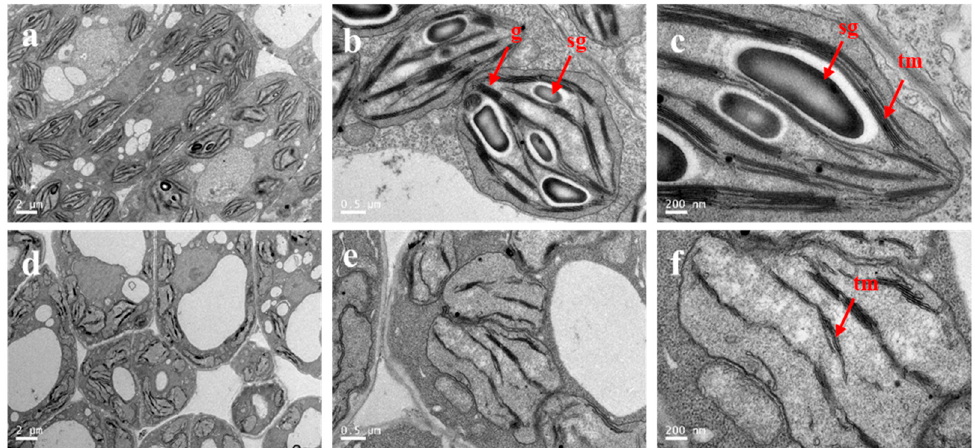
Figure 5. Chloroplast ultrastructure of yl2.1 and wt-WD1. Chloroplast structure of wt-WD1 ( a – c ) and yl2.1 ( d – f ). sg = starch granules; tm = thylakoid membranes; g = grana. Scale bar is shown in the figure.